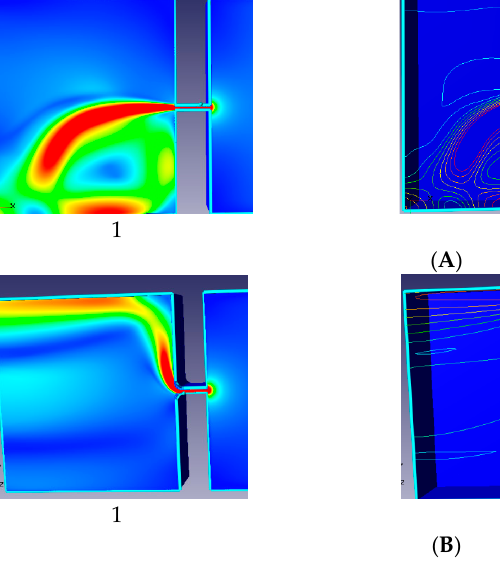
(cid:3043) (cid:3117) = 1.4 (cid:4673) . (cid:3043) (cid:3118)